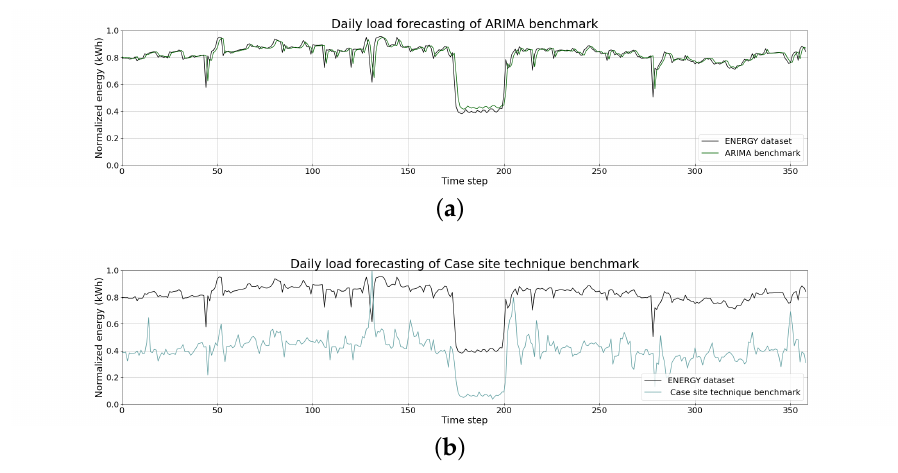
Figure 11. Daily load forecasting using ( a ) the case site technique and ( b ) the ARIMA model.